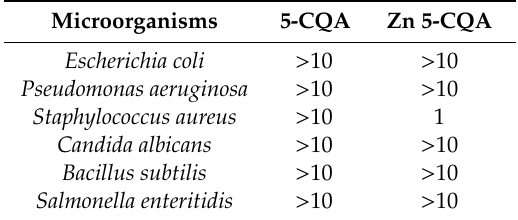
Table 2. The minimum inhibitory concentration (MIC) values (mM) for 5-CQA and Zn 5-CQA against selected